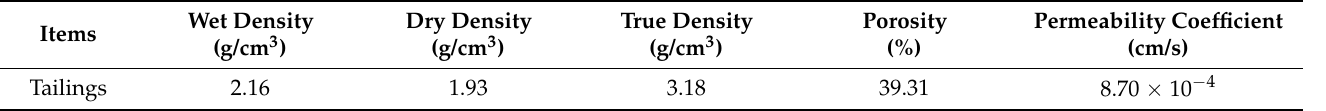
Table 2. Physical properties of tailings.